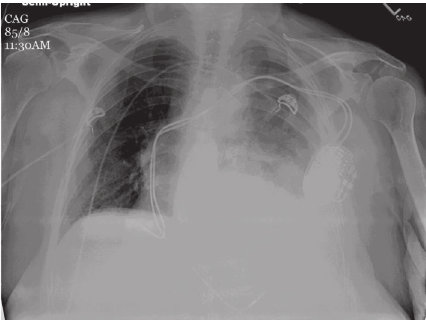
Figure 3: CT scan of chest showing the pacemaker wire extending to the left pleural cavity with a moderate pleural effusion and a small localized adjoining pericardial effusion.